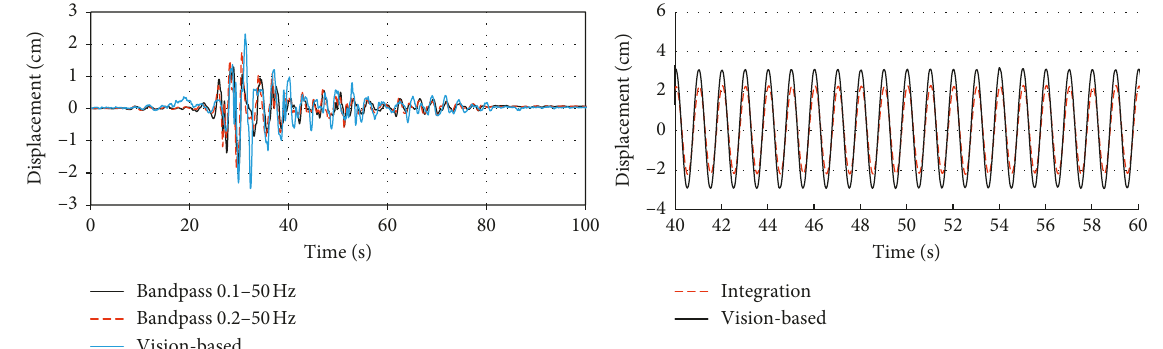
Figure 10: Comparison of displacement between integration and vision-based